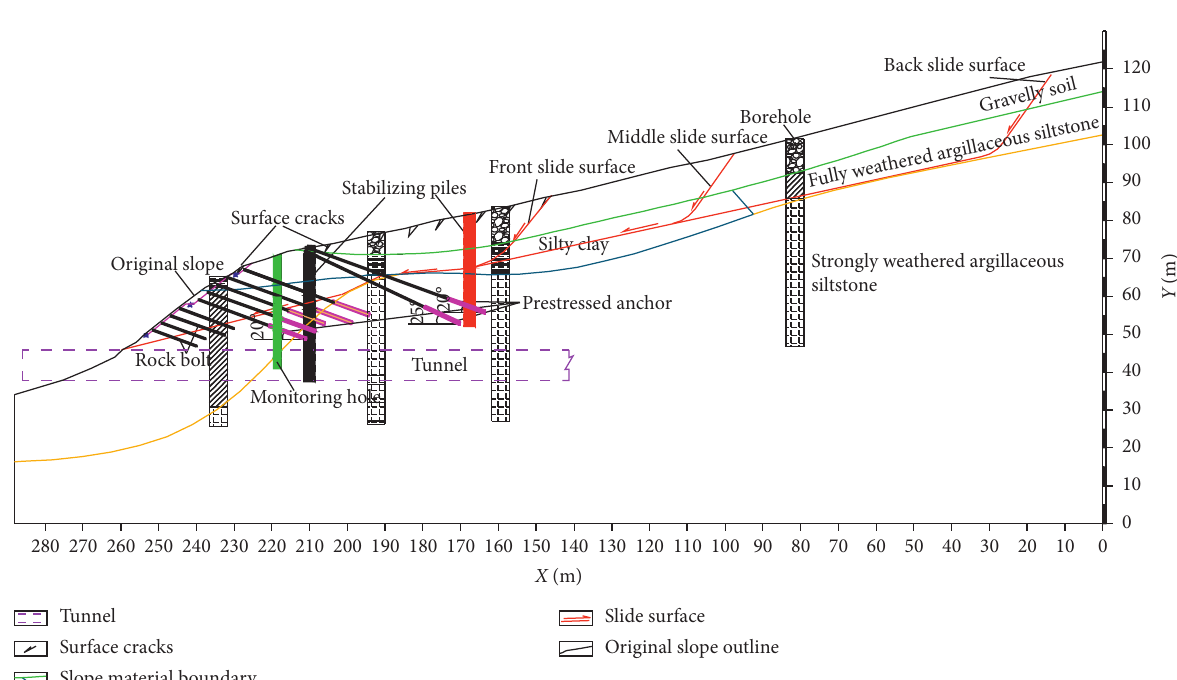
Figure 2: Representative geological profile along cross section 1-1 and the designed reinforcement